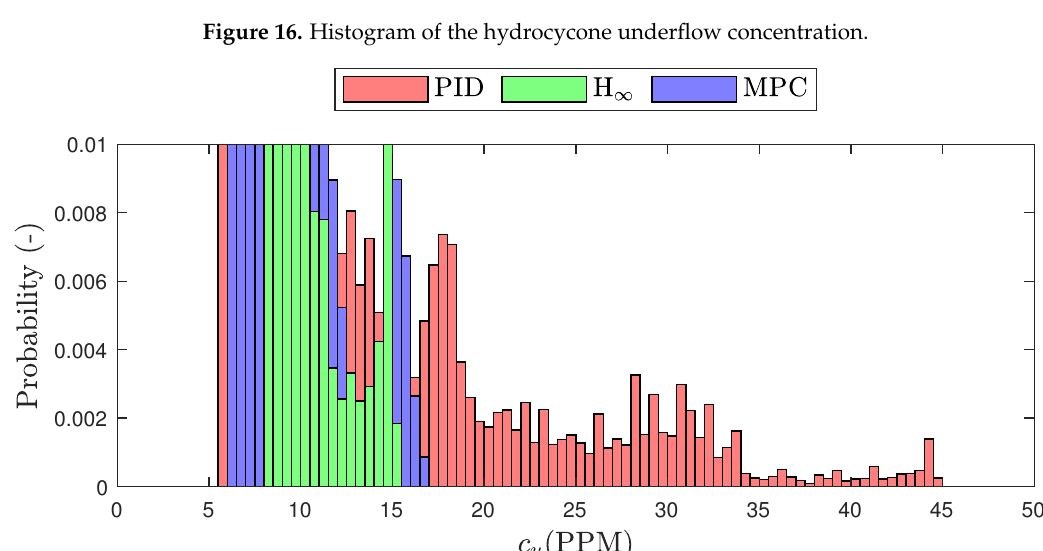
Figure 16. Histogram of the hydrocycone underflow concentration.